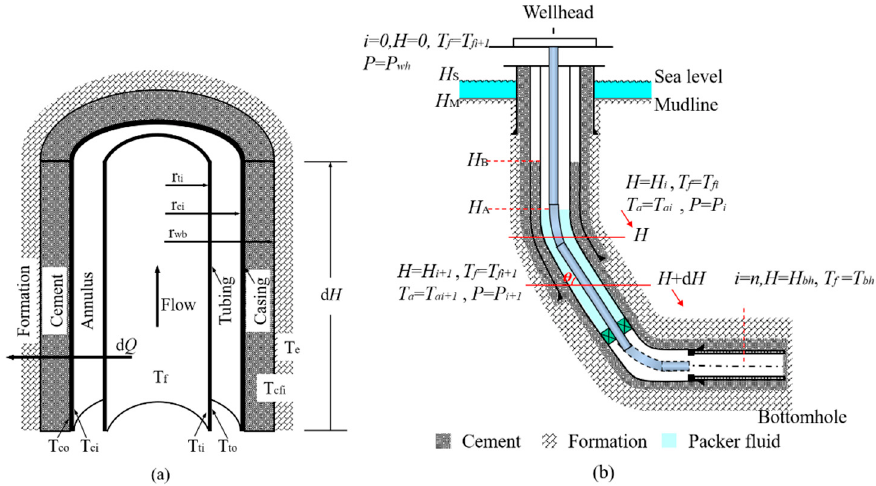
Figure 3. ( a ) Radial heat transfer of the differential element [31]. ( b ) Wellbore calculation model.